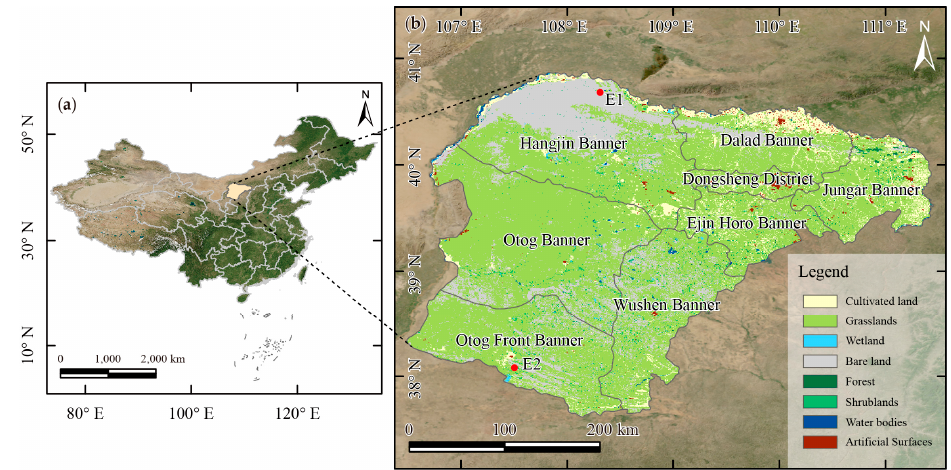
Figure 1. ( a ) Geographic location of the study area; ( b ) Land cover/use of the study area acquired from GlobeLand30 dataset (http://www.globallandcover.com/). Red dots marked E1 and E2 in sub-figure ( b ) show the locations of satellite images used in Figures 11 and 13, respectively.